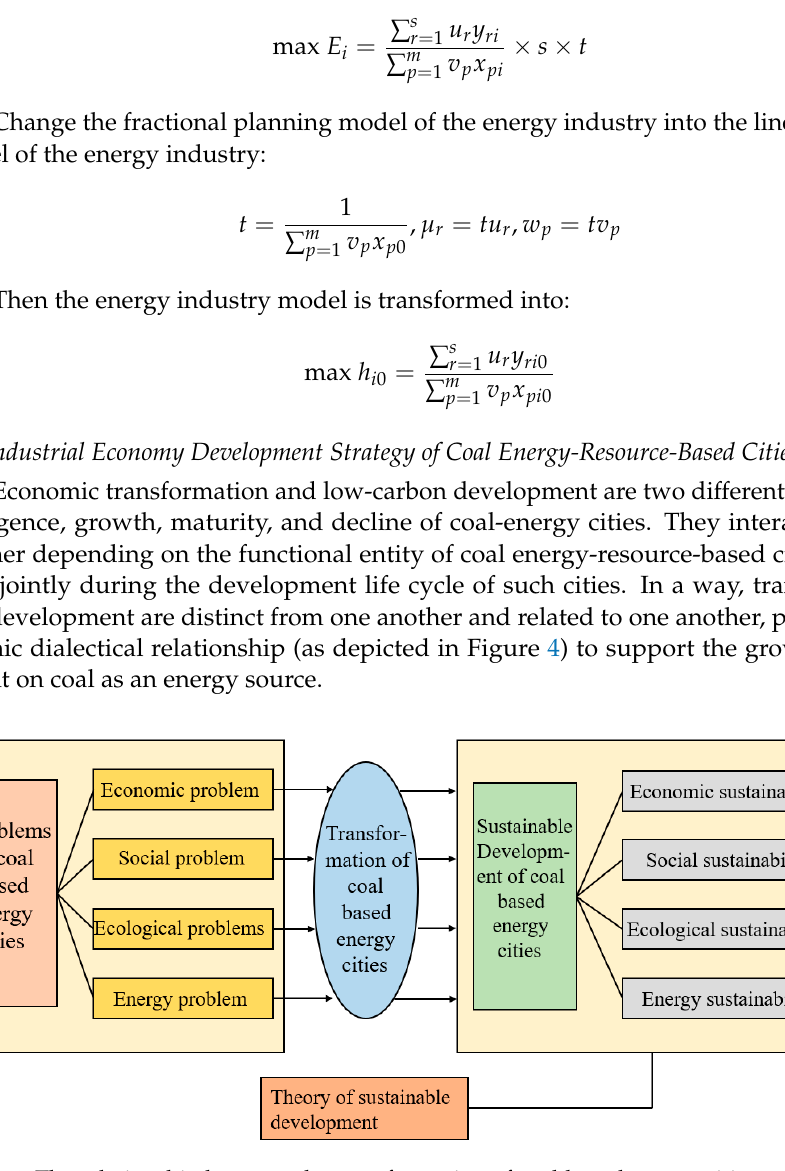
Figure 4. The relationship between the transformation of coal-based energy cities and sustainable development.